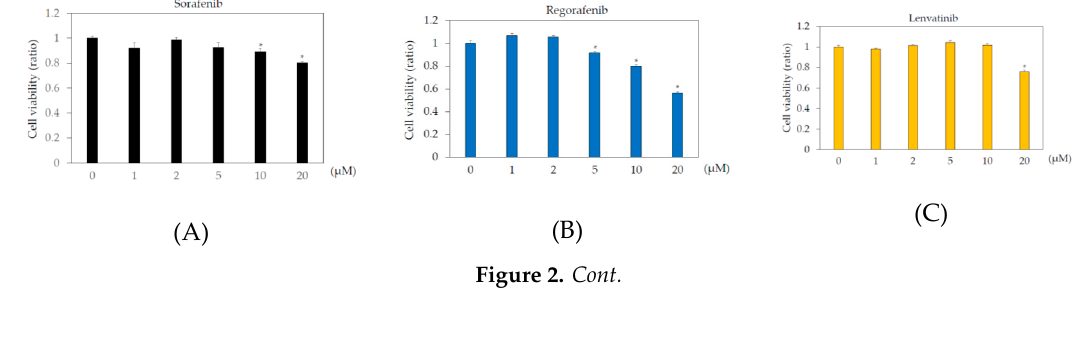
Figure 1. Effects of multiple kinase inhibitors on the Huh7 cell viability cells ( n = 3), ( A ) sorafenib; ( B ) regorafenib; ( C ) lenvatinib. Huh7 cells were treated with sorafenib, regorafenib or lenvatinib at 0, 1, 2, 5, 10, or 20 μ M for 48 h. Cell viability was measured by MTS assay. * p < 0.05, compared to Huh7 treated without multiple kinase inhibitors. Pictures taken by phase contrast microscopy (× 20): ( D ) Huh7 control; ( E ) Huh7 cells treated with 2 μ M regorafenib; ( F ) 20 μ M regorafenib; ( G ) 2 μ M lenvatinib; ( H ) 20 μ M lenvatinib.